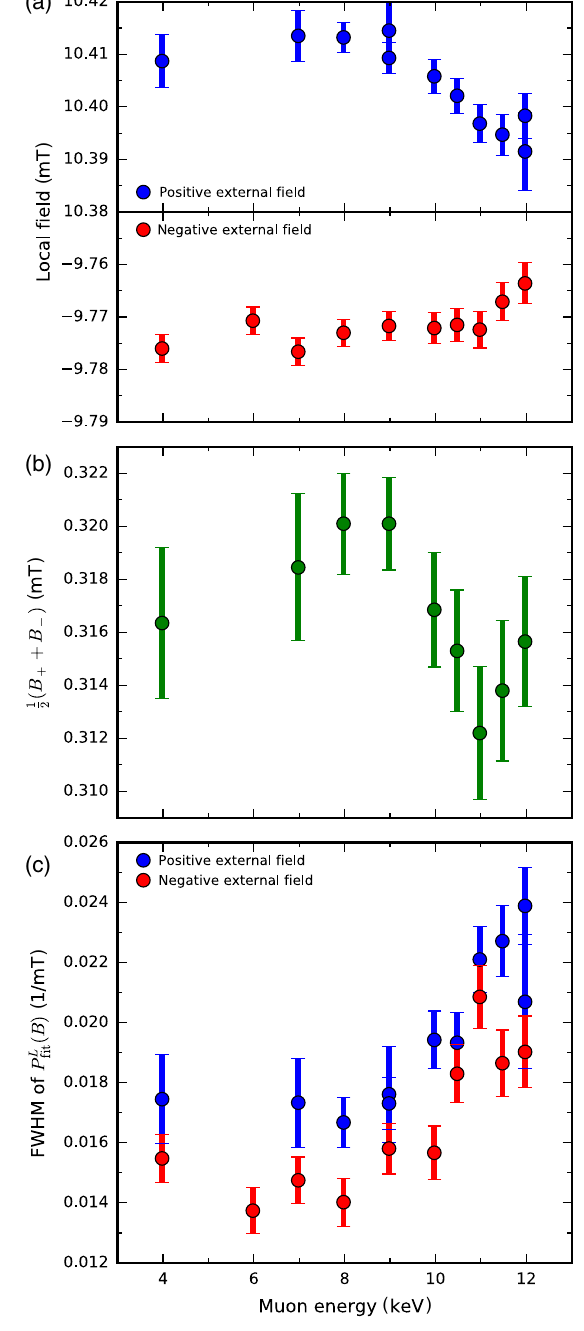
FIG. 8. (a) Measured magnetic field experienced by the muons stopping in the solid nitrogen layer as a function of energy. With increasing implantation energy, the average distance of muons to the Cr 2 O 3 interface decreases. Positive and negative external field refers to the small bias field applied at low temperature for the duration of themeasurement;inbothcases,thesampleispoledinalargepositive field parallel to the external electric field prior to the measurement to prepare it in a single magnetoelectric domain with positive α . (b) Measured local field corrected for contributions from parasitic field effects as a function of the muon implantation energy. (c) Mea- sured FWHM of the magnetic field distribution fit to a Lorentzian distribution P L ð B Þ as a function of the muon implantation fit